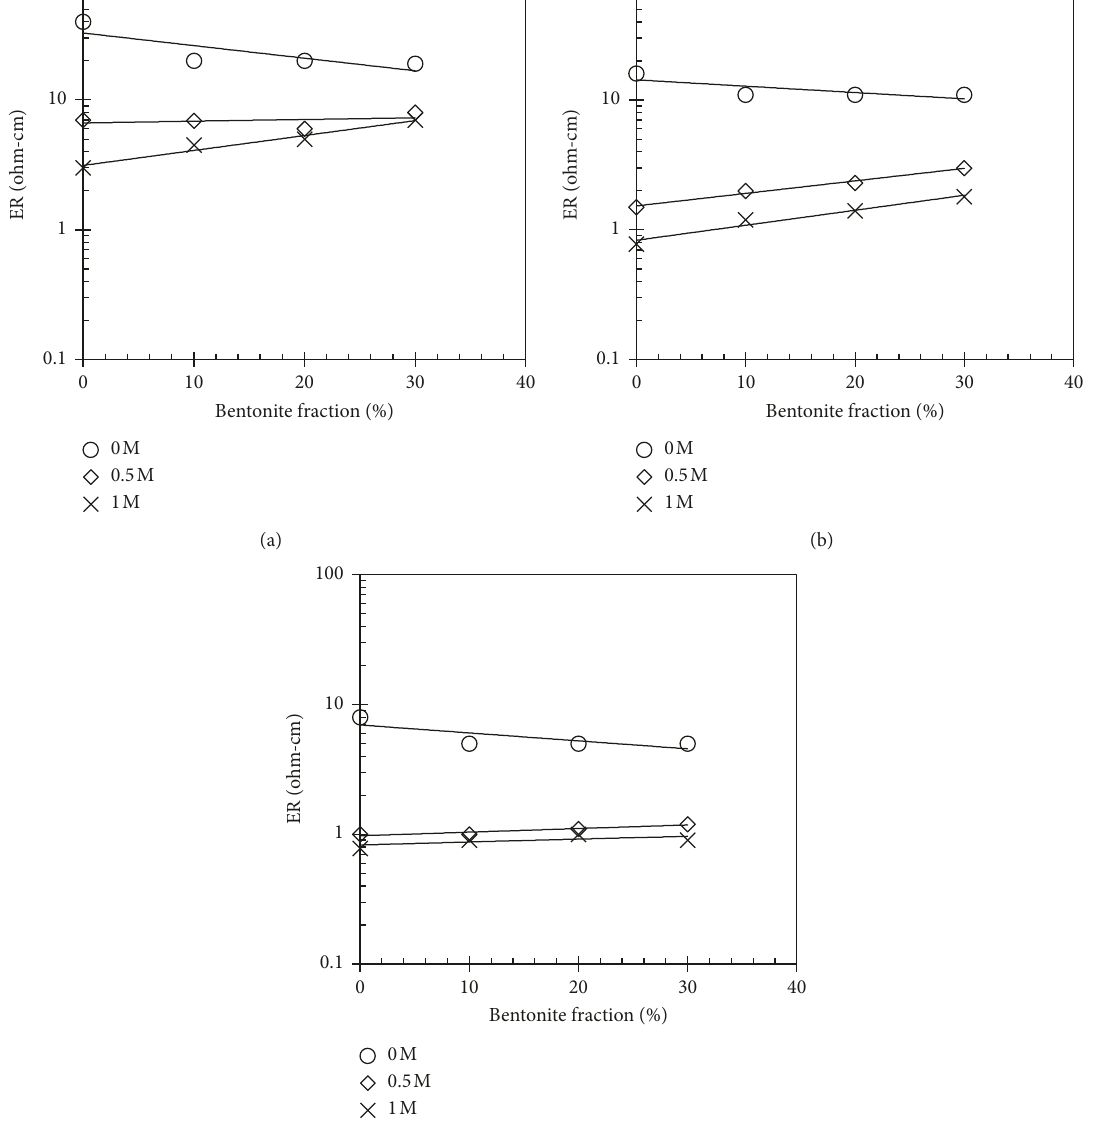
Figure 11: ER against bentonite fraction in NaCl solutions (0M, 0.5 M, and 1M) at (a) W cm 3 ), and (c) W c 25%, ρ d 1.4 (g/cm 3 ) water (cid:31) (cid:31)